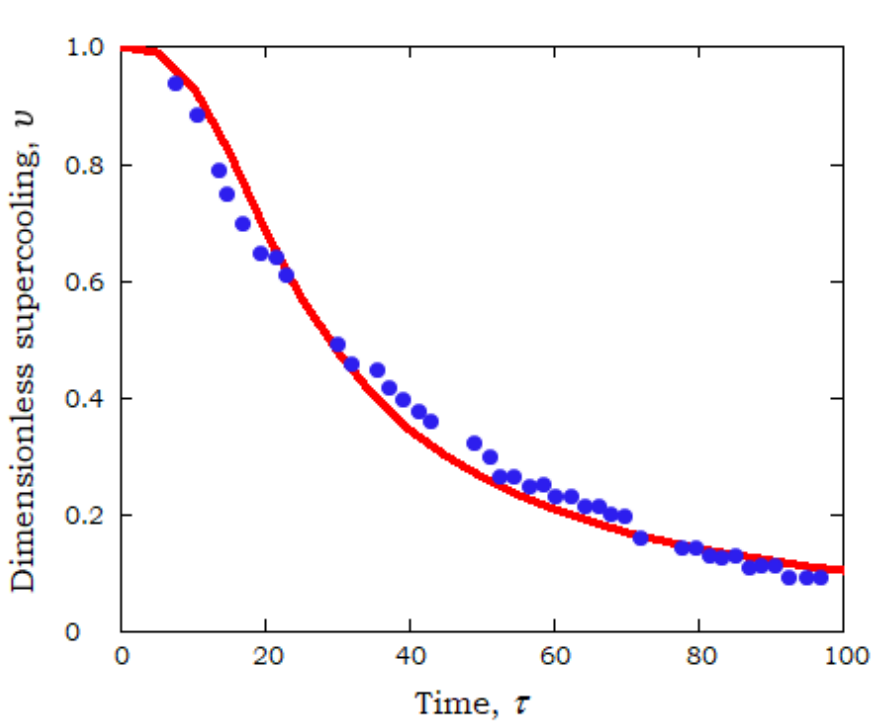
Figure 7. Comparison of theory (solid line) with experiment (dots) [65]. Calculated parameters in Equation (53): u 0 = 10 − 1 , p =